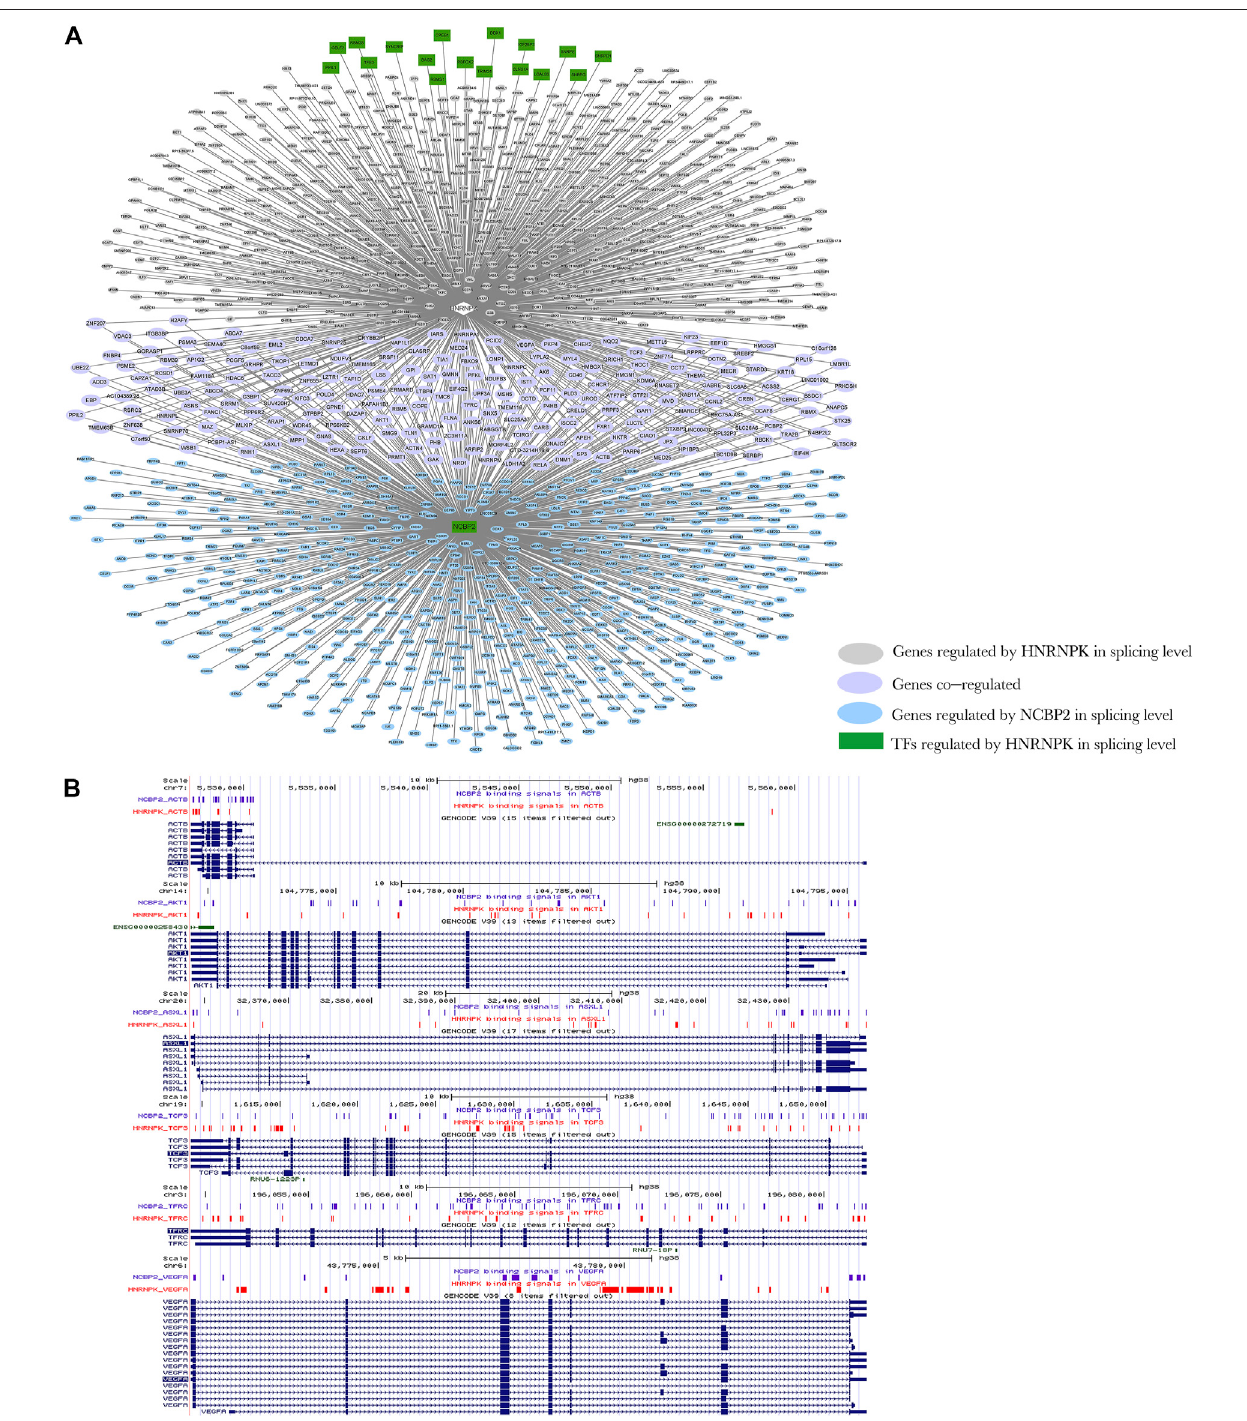
FIGURE 7 | Network diagram of regulation model Ⅱ . (A) Heterogeneous nuclear ribonucleoprotein K (HNRNPK) regulates the transcription of nuclear cap – binding proteinsubunit2(NCBP2),andthenHNRNPKandNCBP2canjointlyregulatethesplicingofgenes.Greenindicatesthegenesthatactassplicingfactors(SFs)regulated by HNRNPK at the transcription level, pink indicates the genes regulated by HNRNPK at the splicing level, purple indicates the genes co-regulated by HNRNPK and NCBP2 at the splicing level, and blue indicates the genes regulated by NCBP2 at the splicing level. Rectangles indicate the target genes of HNRNPK at the transcription level, and ellipse indicates the target gene of HNRNPK and NCBP2 at the splicing level. (B) The binding regions of HNRNPK and NCBP2 in splicing target genes,ACTB, AKT1, ASXL1, TCF3, TFRC, and VEGFA. Input theChIP-seq data ofHNRNPK and NCBP2 intothe UCSCGenomeBrowser toobtain thepositionimage ofpeakinthegenome.Purpleandredindicatetheproteinbindingsites,andblueindicatesthelocationofgenesinthegenome.Formoredetailedinformationongenesin the network, please refer to Supplementary Table S8 .